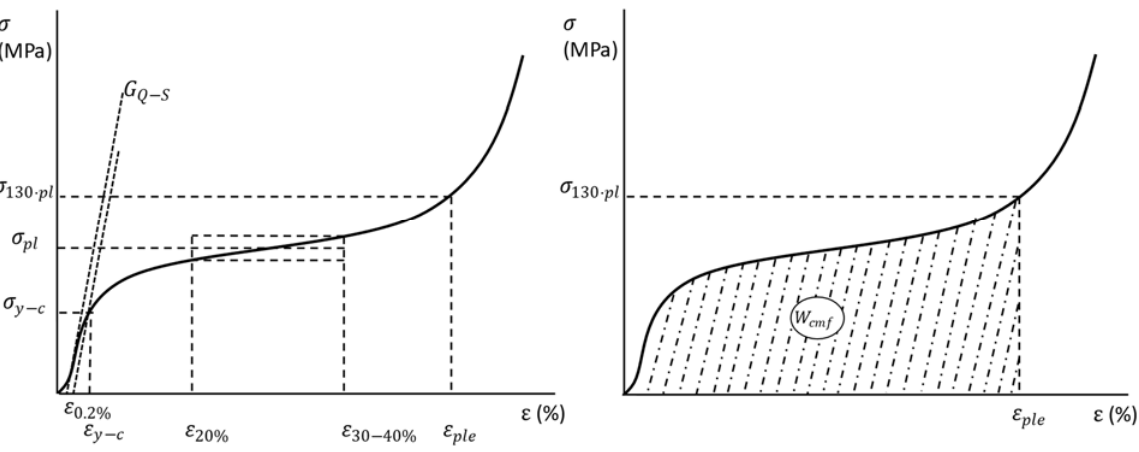
Figure 2. Graphical obtention of mechanical properties based on the stress–strain curve according to the standard used. the standard